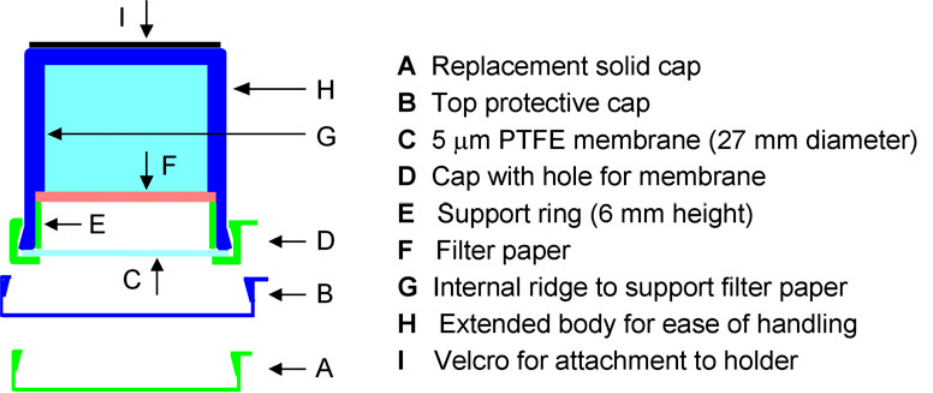
FIGURE 5 . The new CEH ALPHA